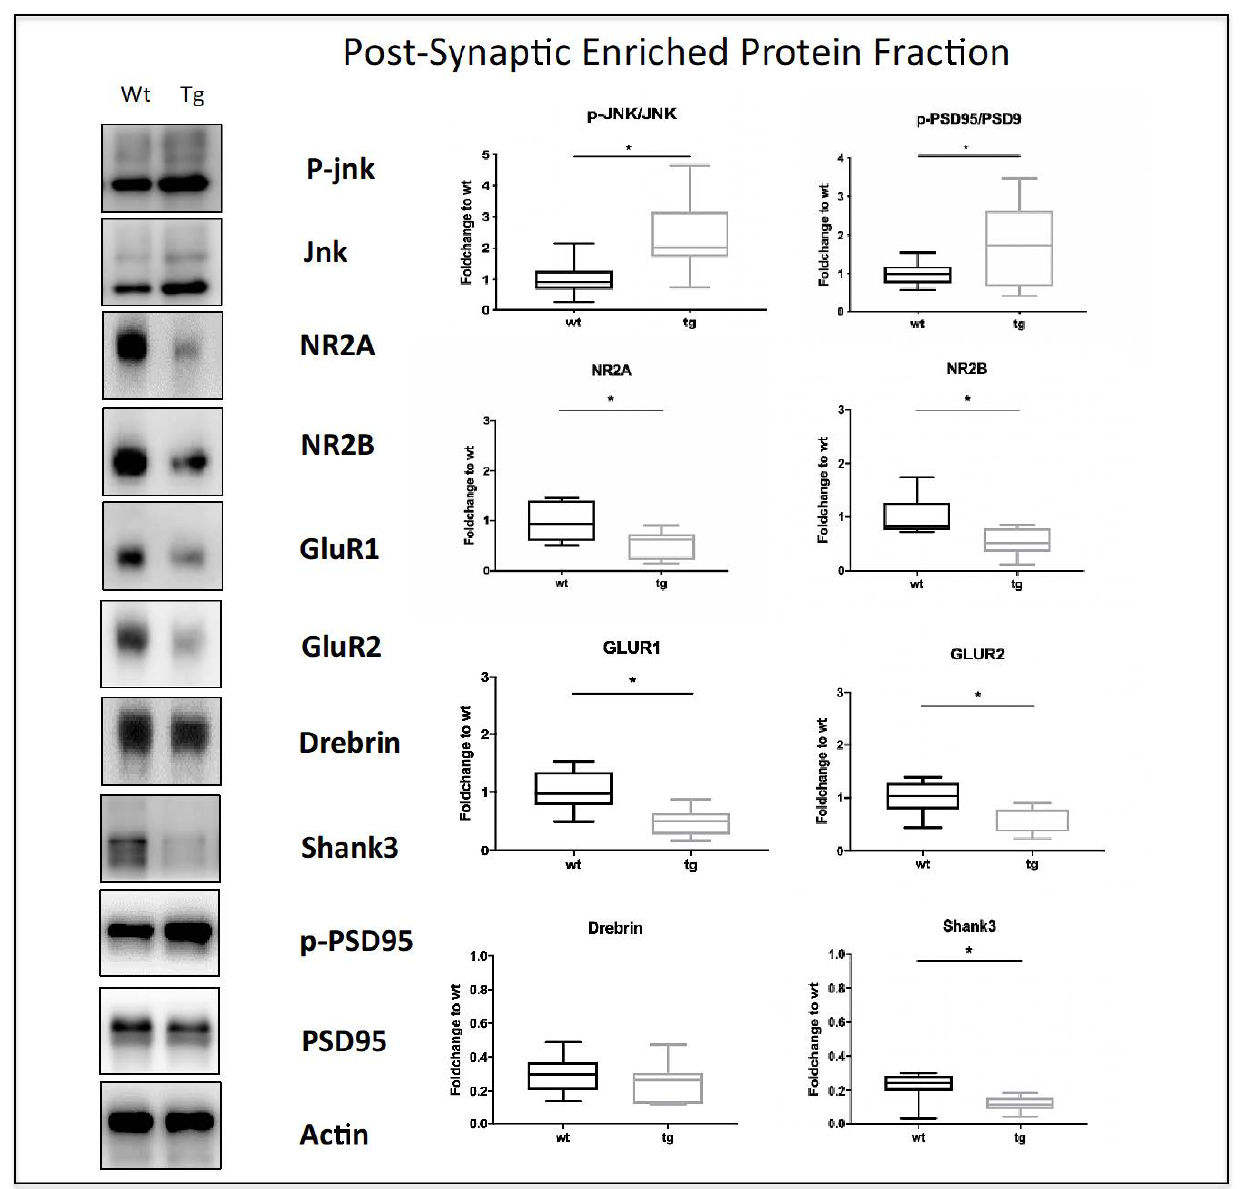
Figure 3. Synaptic dysfunction in the cortical post-synaptic proteins enriched fraction of 3.5-month-old mice. Representative Western blots and relative quantifications of 3.5-month-old mice TIF cortex show JNK signaling activation in tg compared to wt mice and increased levels of p-PSD95/PSD95 ratio together with decreased levels of NR2A, NR2B, GluR1, GluR2, and Shank3 levels. Genotypes are compared using t -tests. Statistical significance: * p < 0.05. Data are expressed as mean ± SEM.